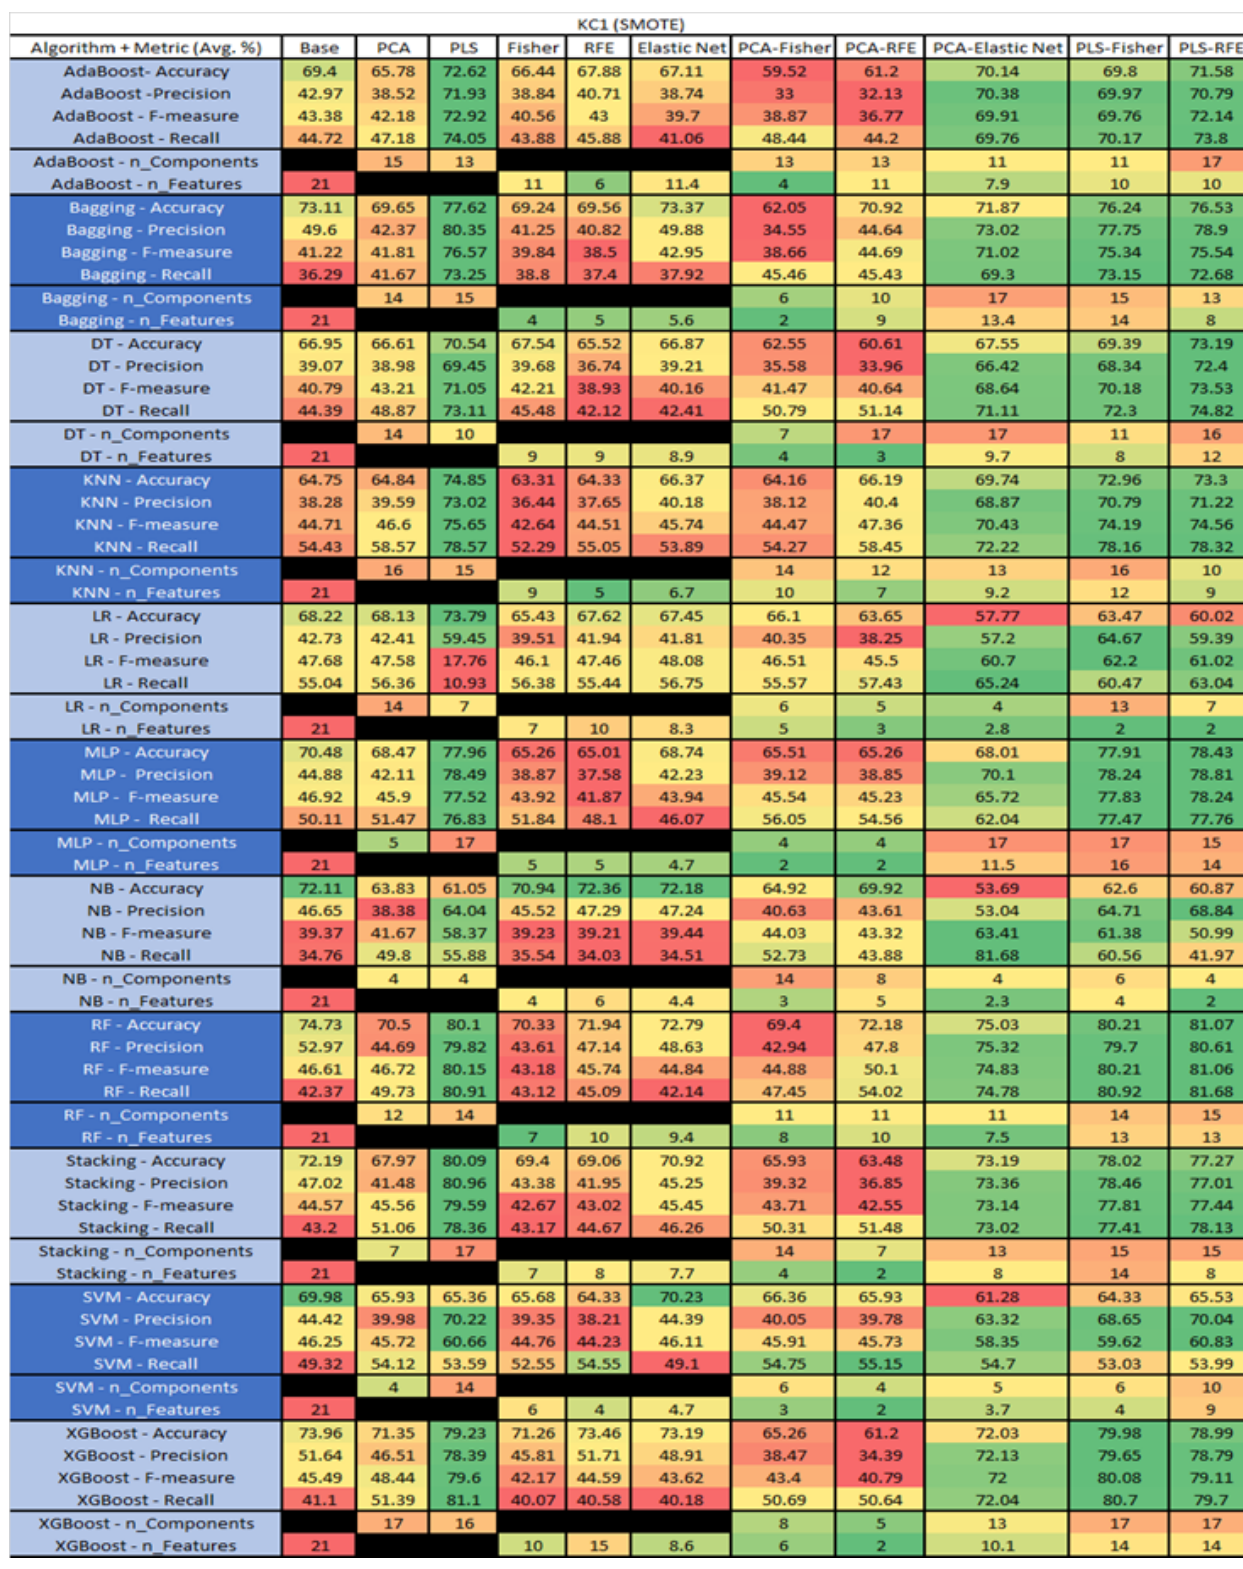
Figure 27. KC1 SMOTE NASA MDP Results Data